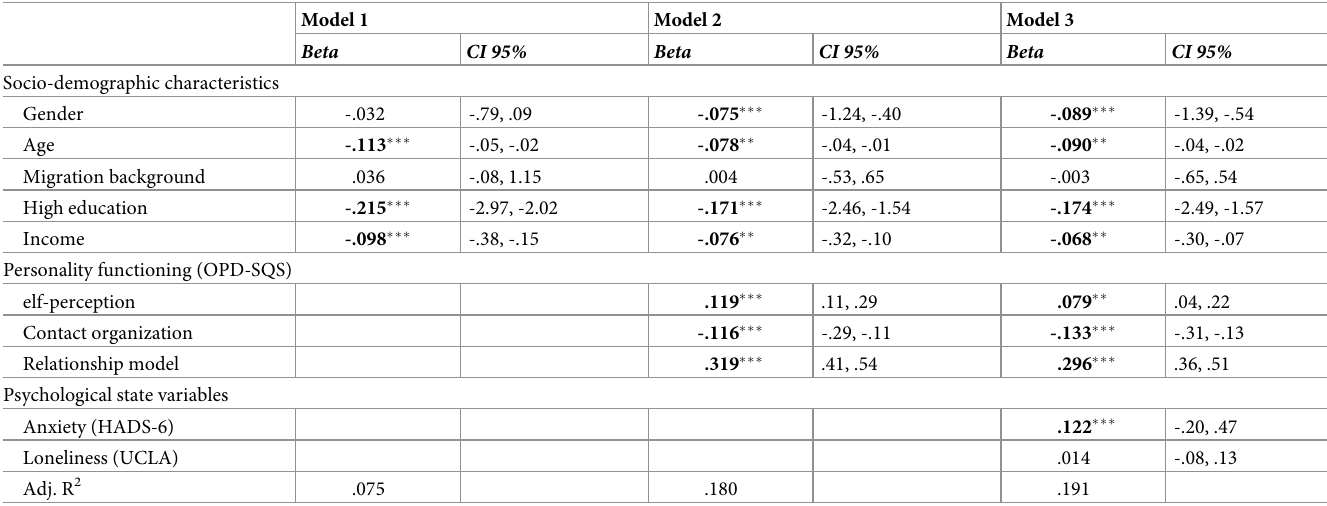
Table 3. Linear regression analyses of conspiracy mentality on socio-demographic characteristics, personality functioning, and psychological state